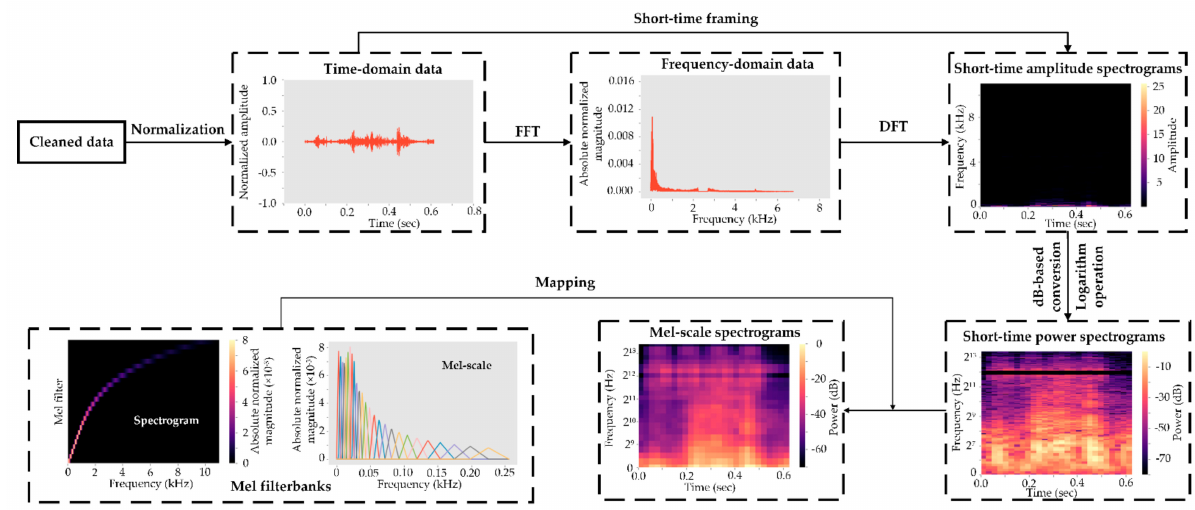
Figure 6. Overall workflow for the Mel-frequency cepstral coefficient processing. FFT is Fast Fourier transform, and DFT is Discrete Fourier Transform. Multiple mel-scale spectrograms were produced based on the short-time framing on time-domain